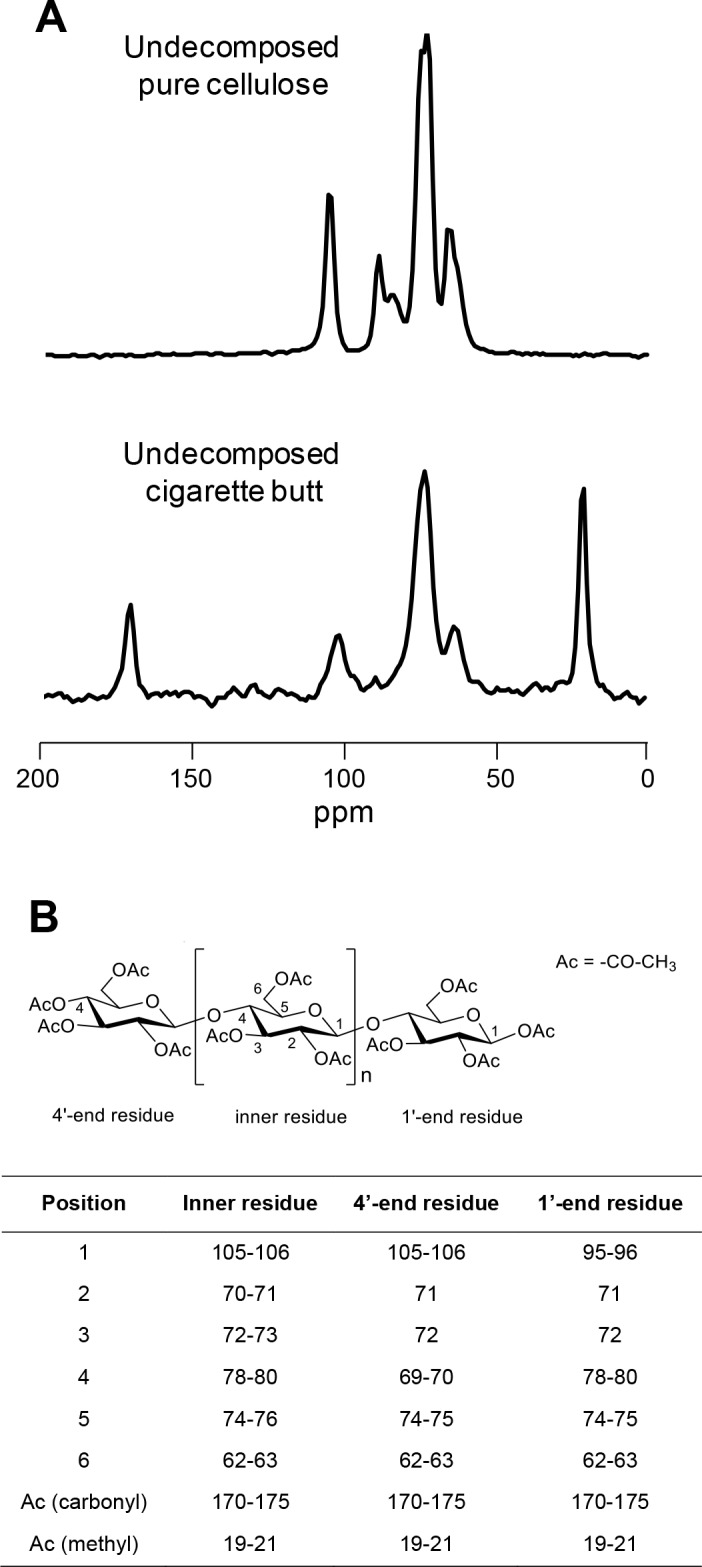
CB biochemistry assessed by 13C CPMAS NMR.
13C CPMAS NMR spectra of undecomposed pure cellulose paper filter and smoked cigarette butts (A). 13C CPMAS NMR data of acetyl-cellulose are also reported (B). The assignments were obtained by comparing our data with those reported in the literature for glucose acetate [29].